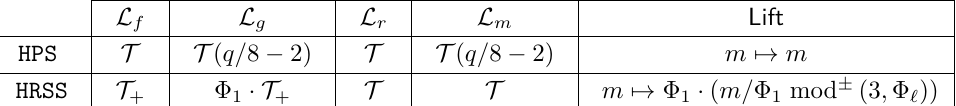
Table 1: Definitions of polynomial sets and lifting application for NTRU-HPS and NTRU-HRSS . L f